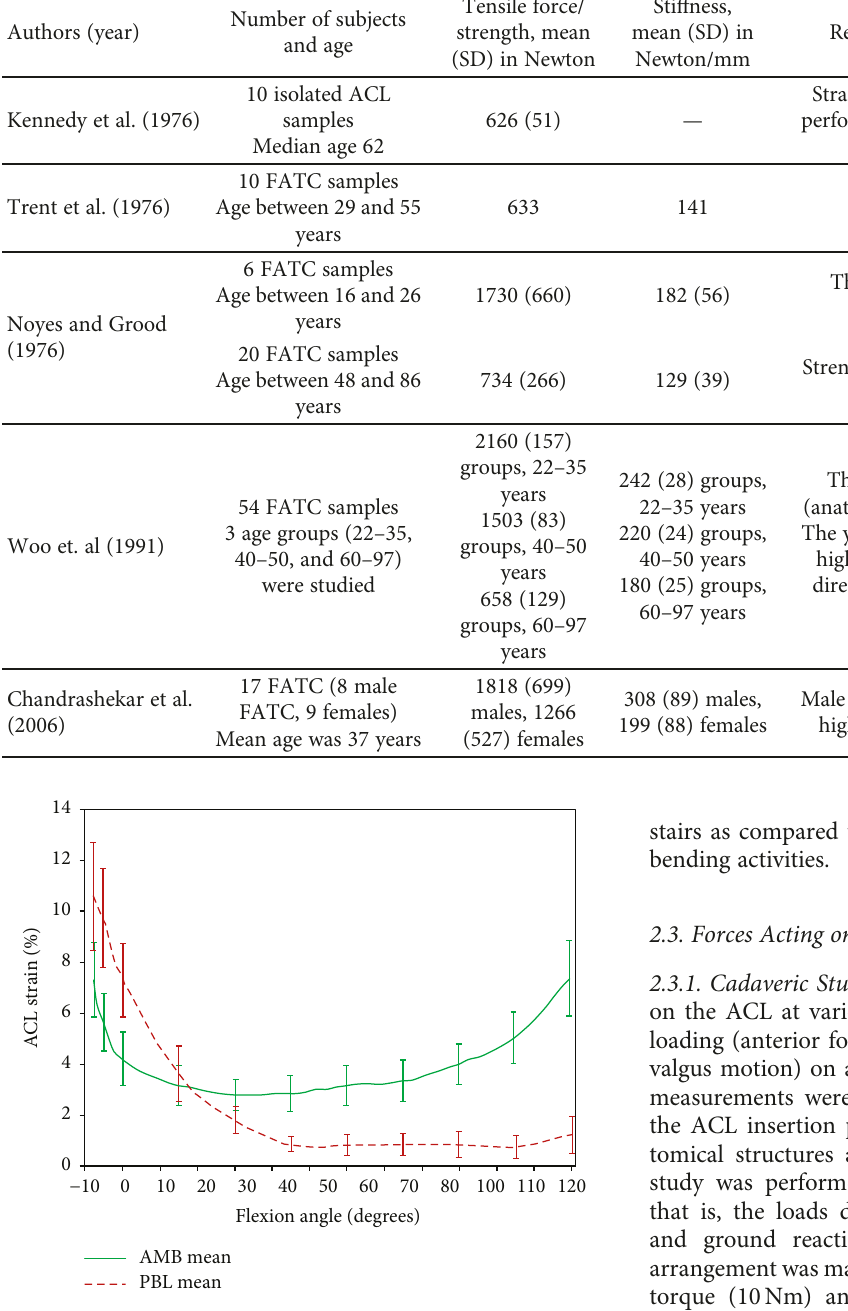
Figure 5: Average strain in AMB and PLB as a function of knee fl exion angle; as shown in the fi gure, AMB is under tension during the extension at the knee joint and PLB is under tension during fl exion